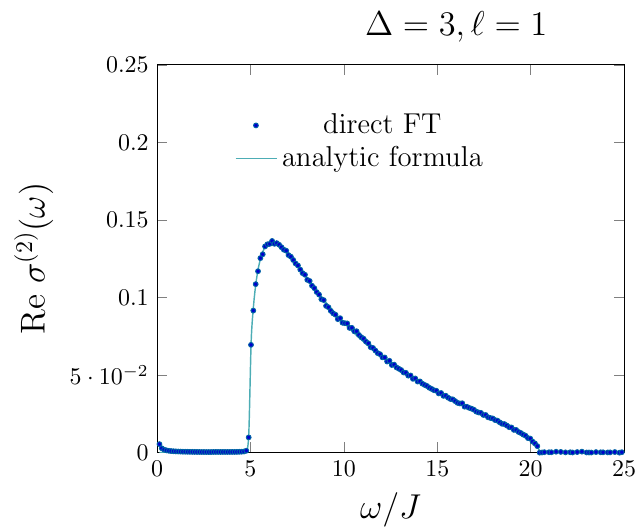
(cid:10) J (cid:11) ( t ) J for anisotropy ∆ = 3. For the latter we use m + 1 1